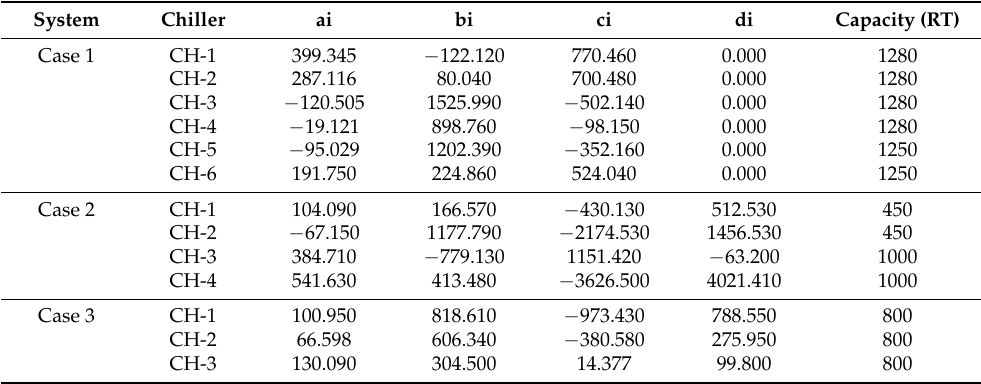
Table 6. Coefficients of power curve of chillers in 3 cases.